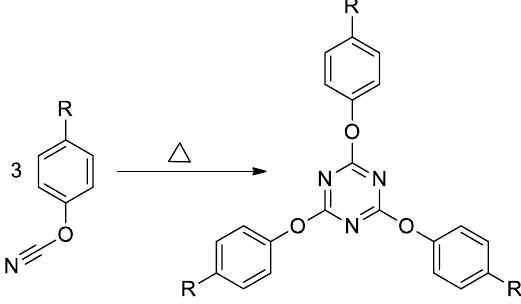
Figure 6. Scheme of cyclotrimerization of cyanate ester.